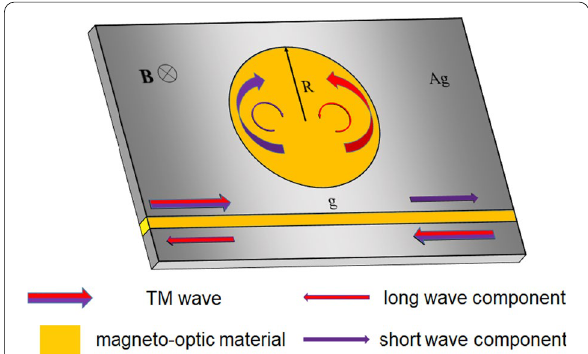
Fig. 1 Schematic illustration of the optical isolator structure composed of a MIM waveguide and a disc cavity. The MIM waveguide and the disc cavity are filled with magneto-optical material and remain under a static magnetic